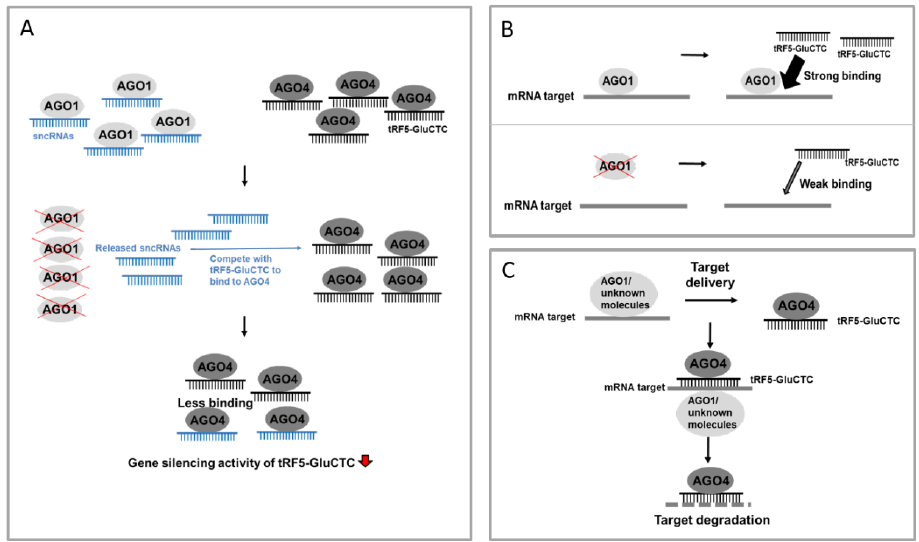
Figure 4. Targeting mechanism models of tRF5-GluCTC. ( A ) In the normal state, RSV-induced